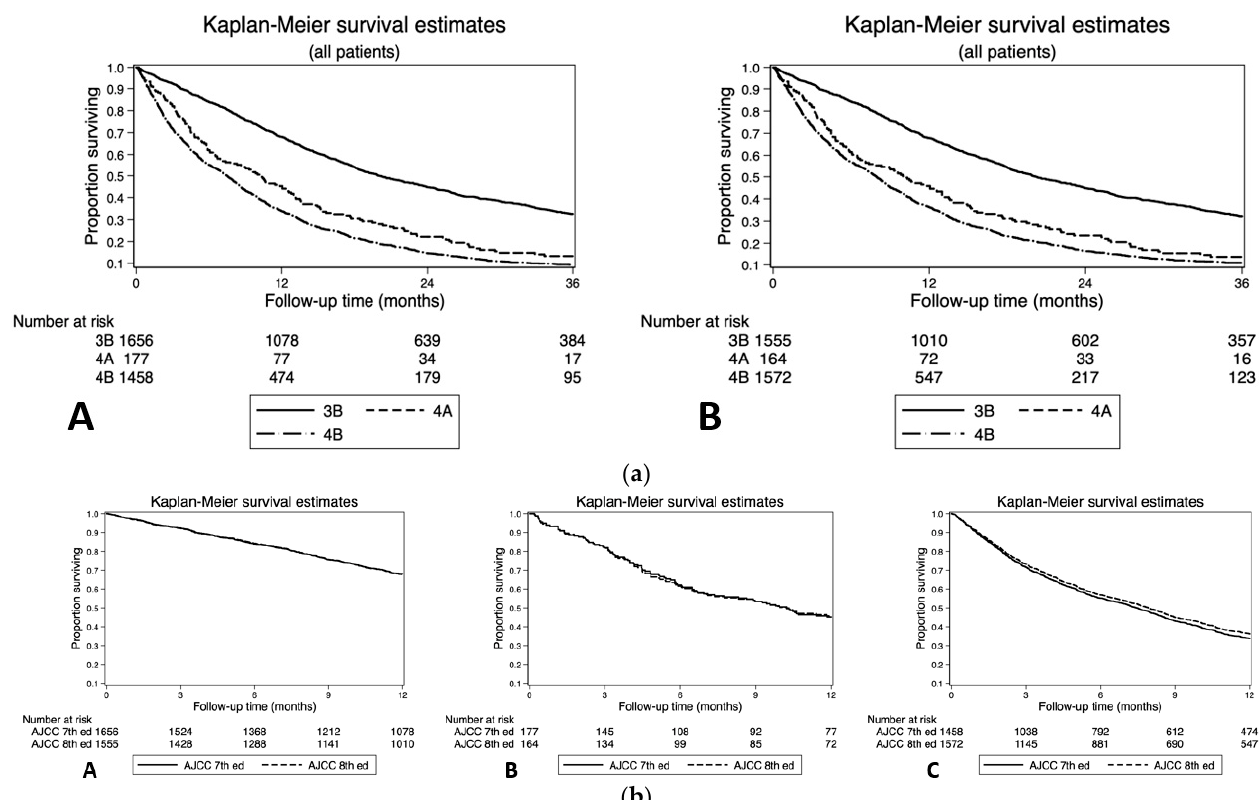
Figure 1. ( a ) Overall survival (OS) of reclassified patients according to the (A) American Joint Committee on Cancer (AJCC) 7th and (B) 8th editions TNM classification. ( b ) Overall survival (OS) pairwise comparison of (A) stage 3B, (B) stage 4A, and (C) stage 4B reclassified patients according to the AJCC 7th and 8th editions TNM classification. Table 2a. AJCC 8th vs. 7th classification of GBC patients from the National Cancer Database (NCDB).